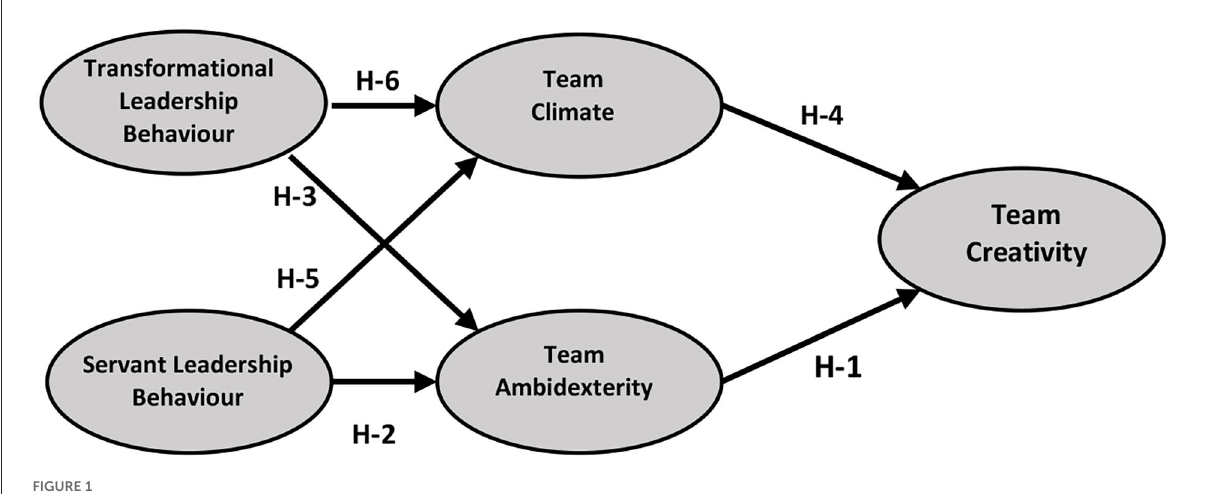
FIGURE1 The theoretical